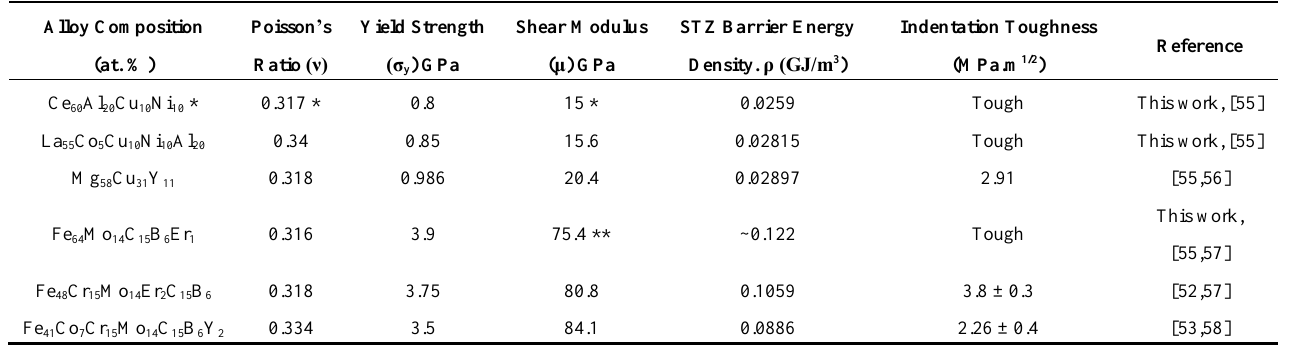
Table 1. Comparison of indentation toughness